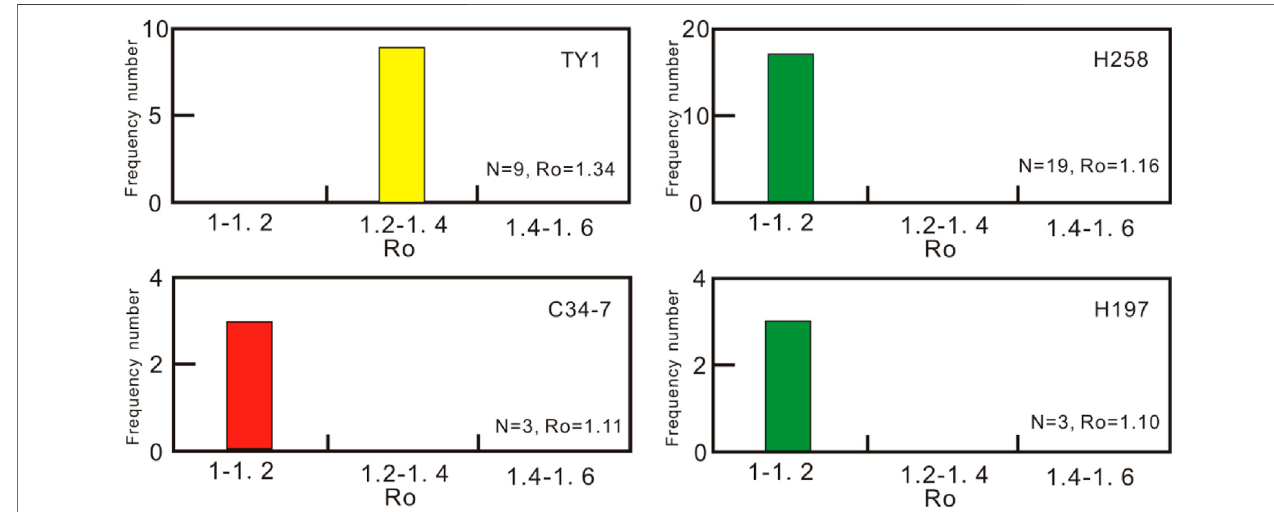
FIGURE 4 | Histograms of vitrinite re fl ectance of K 2 qn 1 in the southern part of the Songliao Basin.